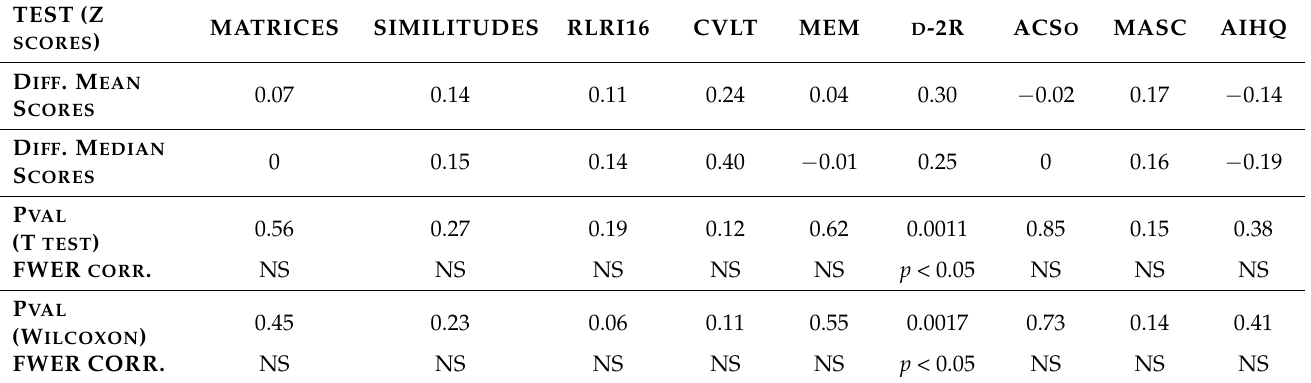
Table 3. Neurocognitive and social cognitive evaluations (Scores Homeless—Scores